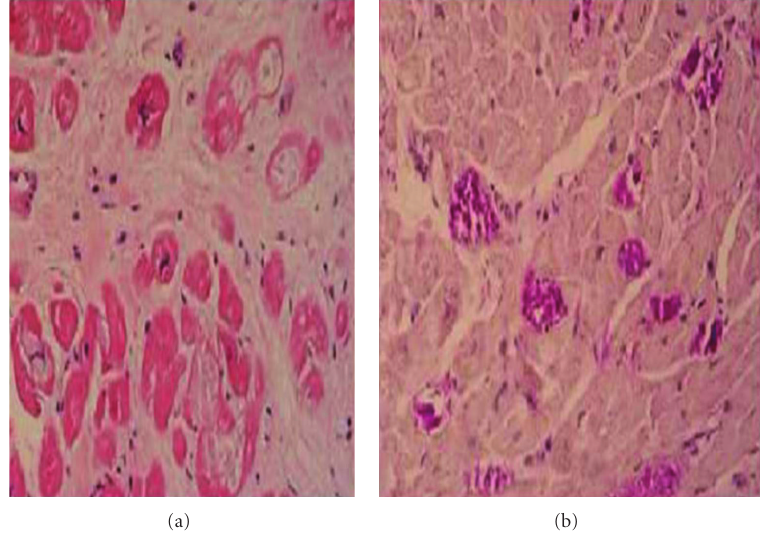
Figure 2: (a) Microscopic findings of the heart showing pale cytoplasmic inclusion-like material within cardiac myocytes; hematoxylin/eosin, × 200. (b) Periodic acid-Schi ff (PAS)-positive, large cytoplasmic inclusions in cardiac myocytes, × 200.